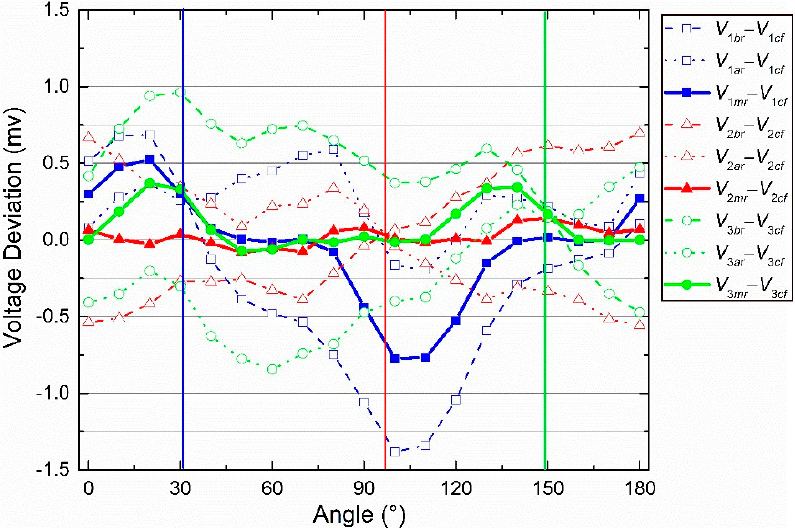
Figure 18. Experimental data analysis when the central-symmetry method is also used.